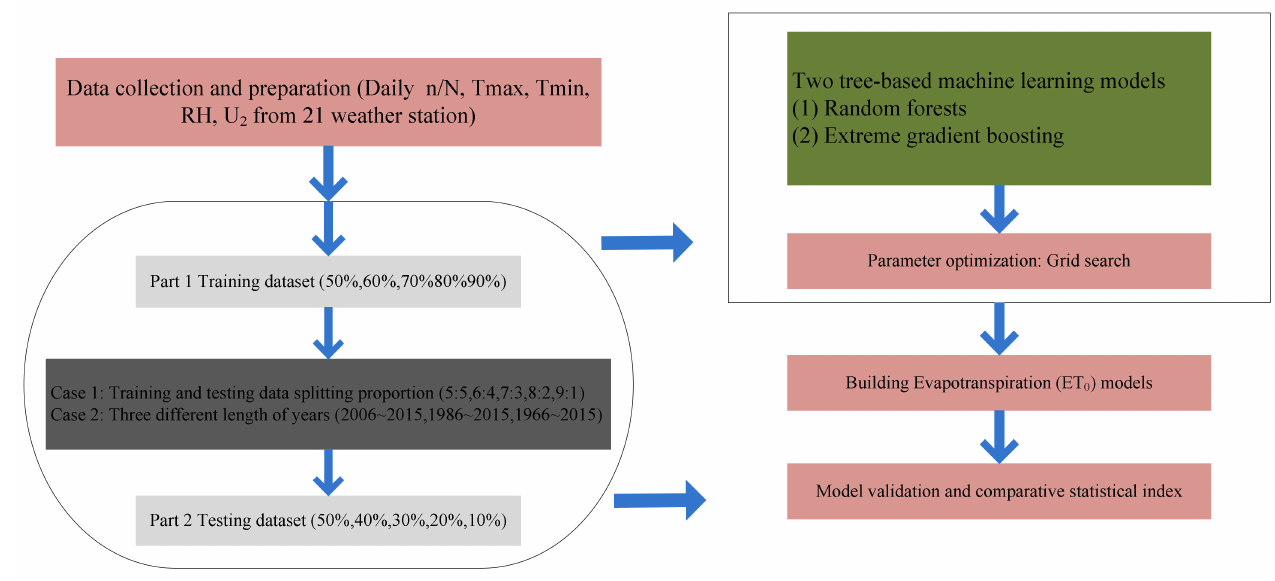
Figure 3. Simple flowchart of the proposed methodology in this